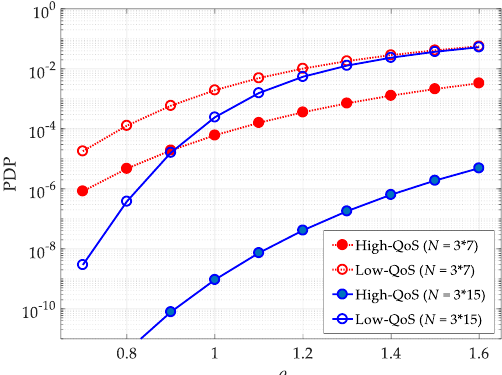
Figure 8. The packet-dropping probability (PDP) of two-level buffering performance versus activity coefficient.